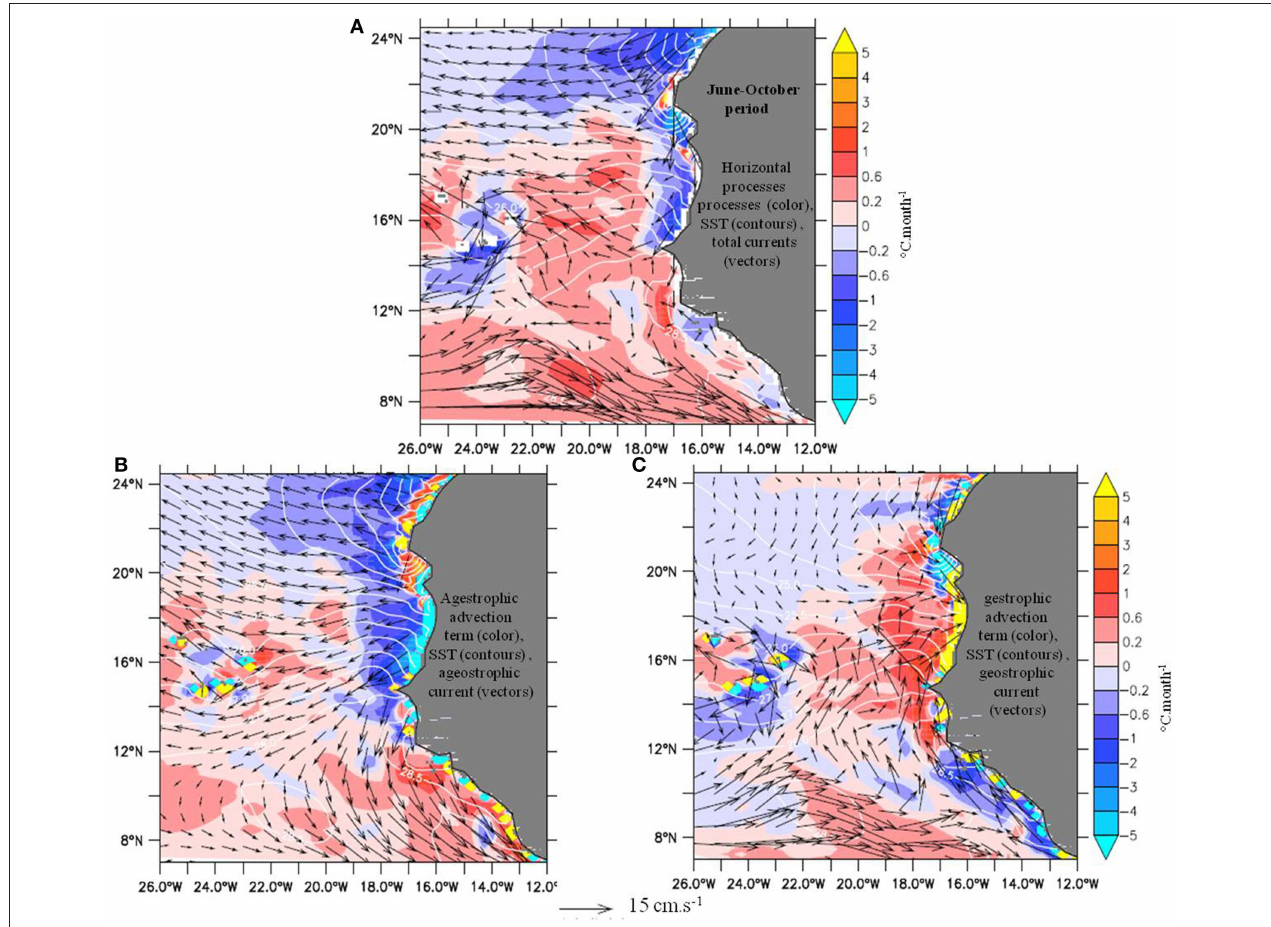
FIGURE 12 | Same as in Figure 8 but over WP